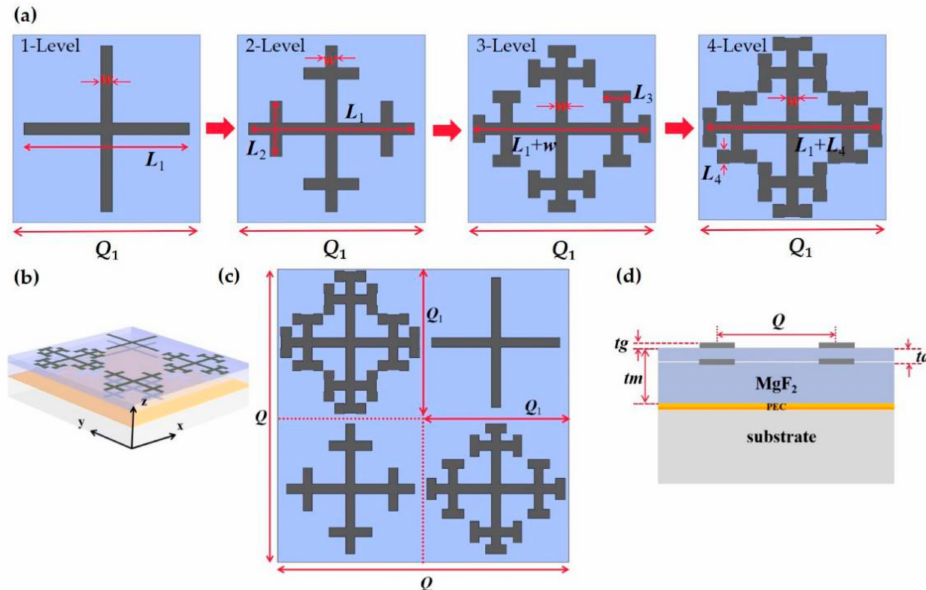
Figure 1. Fractal supercell absorber. ( a ) The evolution of the cross fractal from one to four-level fractals. The three-level and four-level fractals are optimized structures. ( b ) Structure diagram of a tunable broadband terahertz absorber based on fractal technology graphene. ( c ) Supercell synthesized by one- to four-level fractals. ( d ) Side of supercell